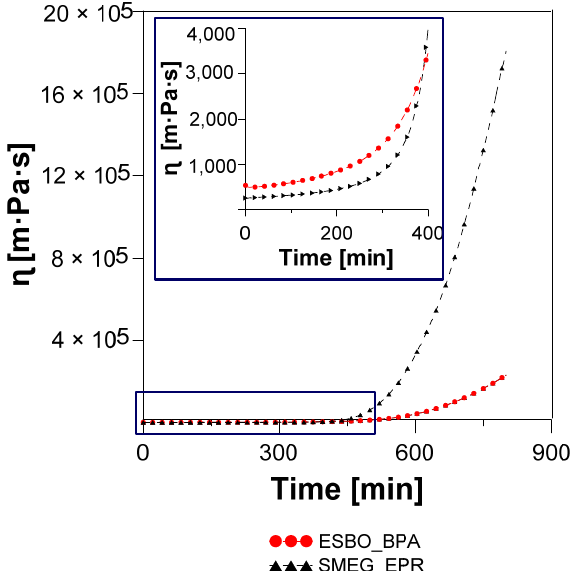
Figure 11. The course of changes in dynamic viscosity during the polyaddition reaction of modified soybean oil with BPA or EPR 0162 conducted in bulk, via the fusion process. Polyaddition products at t = 800 min of conducting the process are characterized by the dynamic viscosity of: 2.3 × 10 2 and 1.8 × 10 3 Pa · s, respectively for ESBO_BPA and SMEG_EPR.